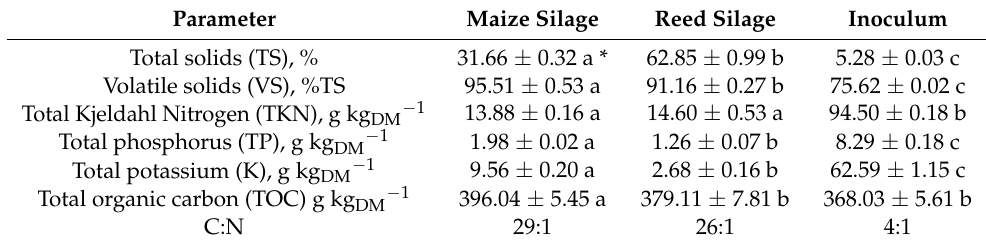
Table 1. Chemical composition of feedstock and